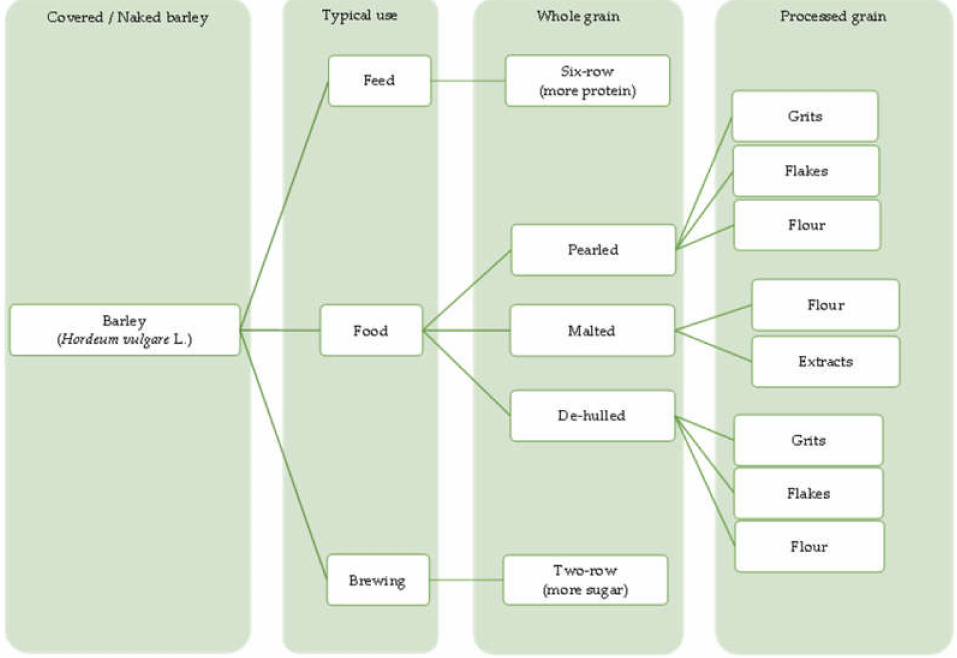
Figure 1. Barley grain